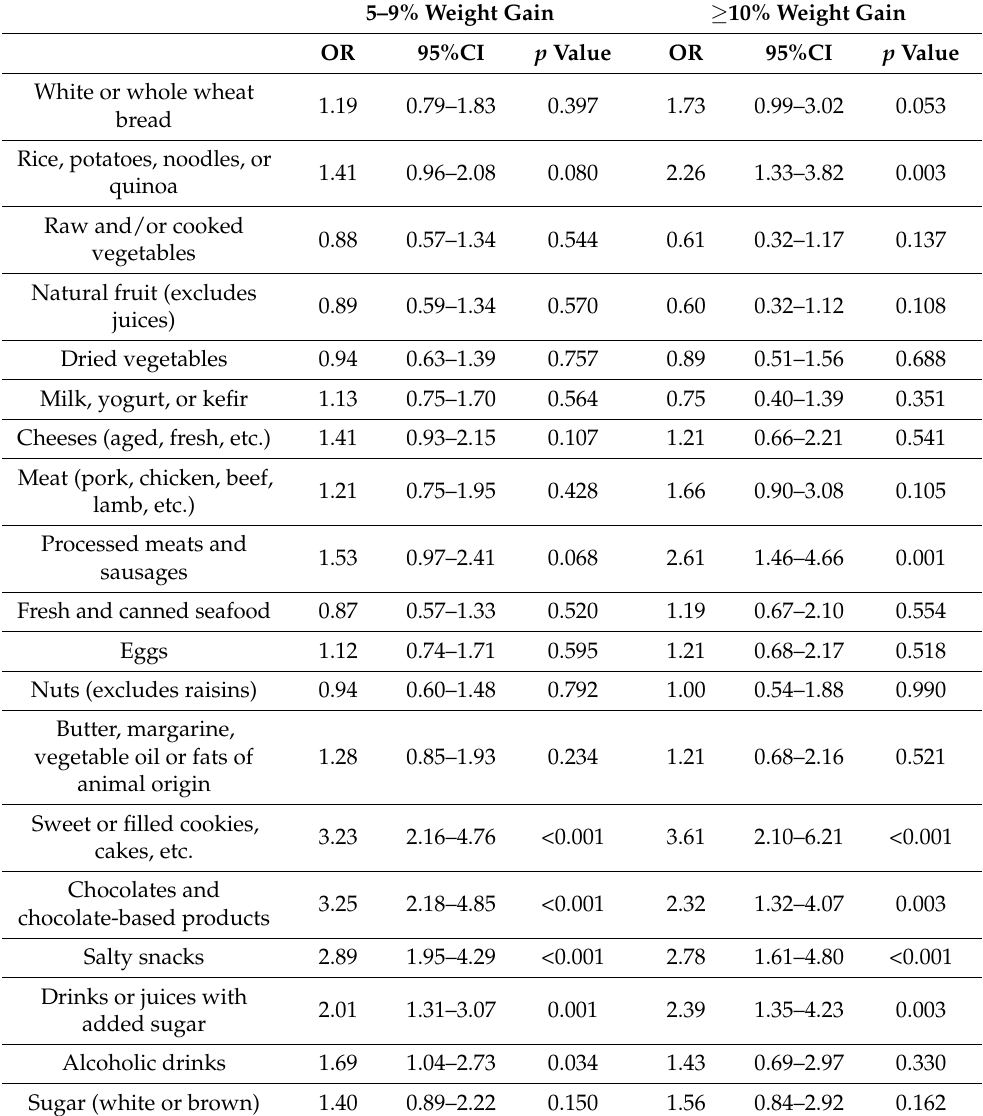
Table 5. Results of the multinomial logistic regression analysis to determine the odds of 5–9% or ≥ 10% self-reported weight gain due to higher self-reported dietary intake during